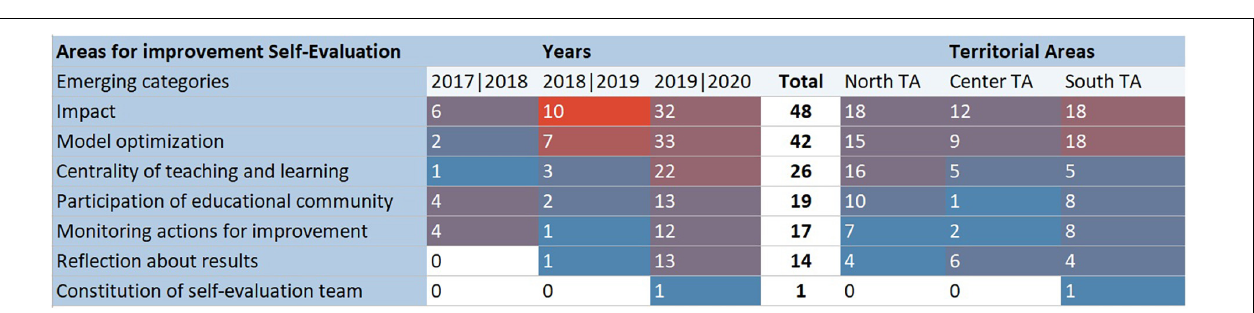
FIGURE 2 | Self-evaluation: strengths. The distribution of coded segments by subcategories, year, and territorial area (TA).